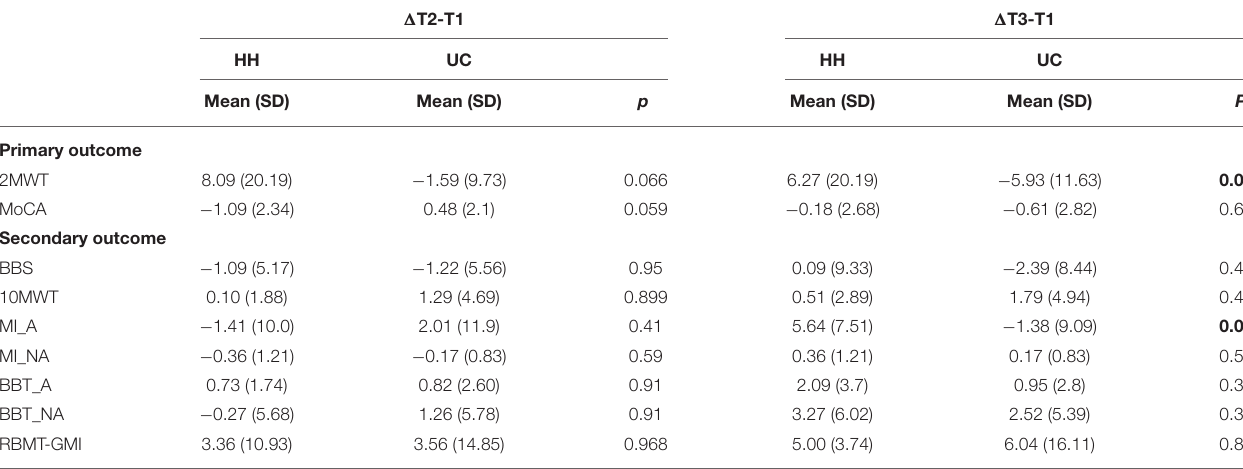
TABLE 4 | Comparison between UC and HH groups on neuropsychological and motor measures after 3-months of HomeHEAD/UC ( 1 T2-T1) and after 6-months from ClinicHEAD ( 1